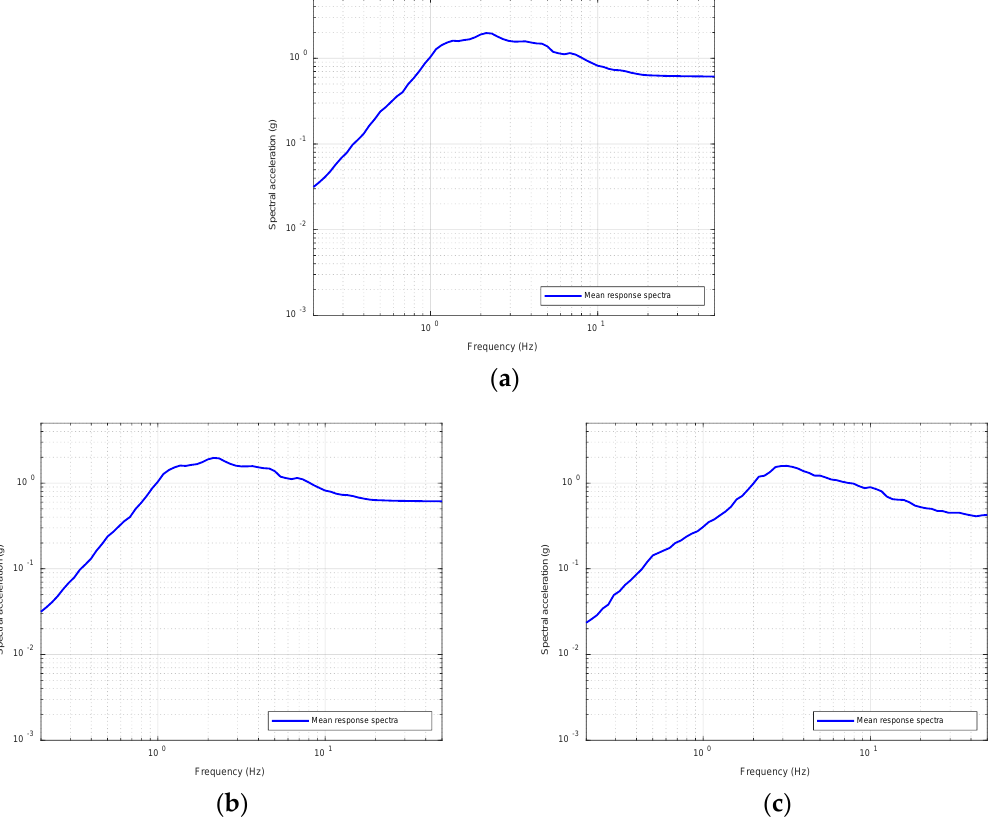
Figure 6. Mean response spectra of the surface ground motions obtained from site response analysis: ( a ) H1; ( b ) H2; ( c )